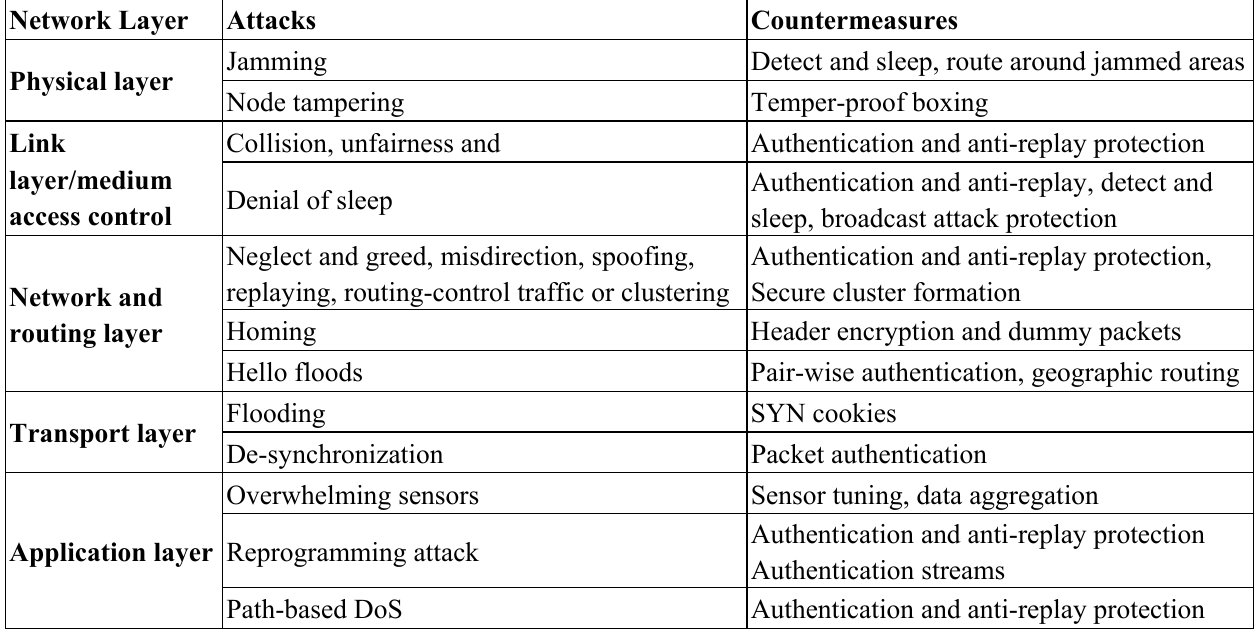
Table 3. Denial-of-Service attacks and countermeasures at each network